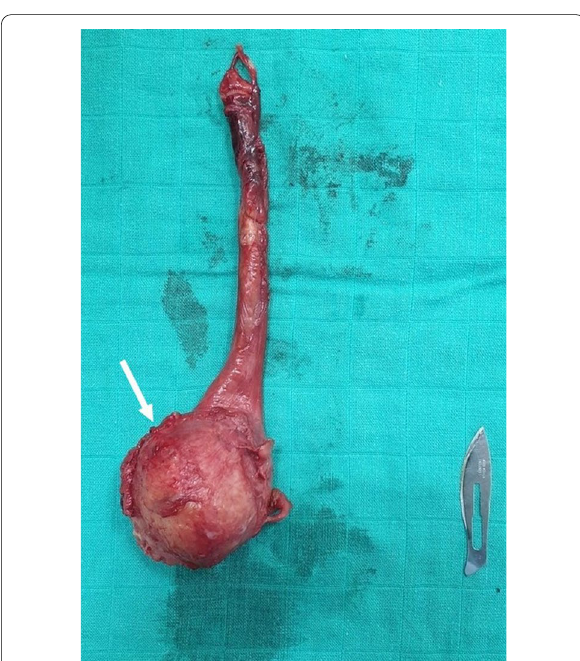
Fig. 3 Postoperative picture of orchiectomy